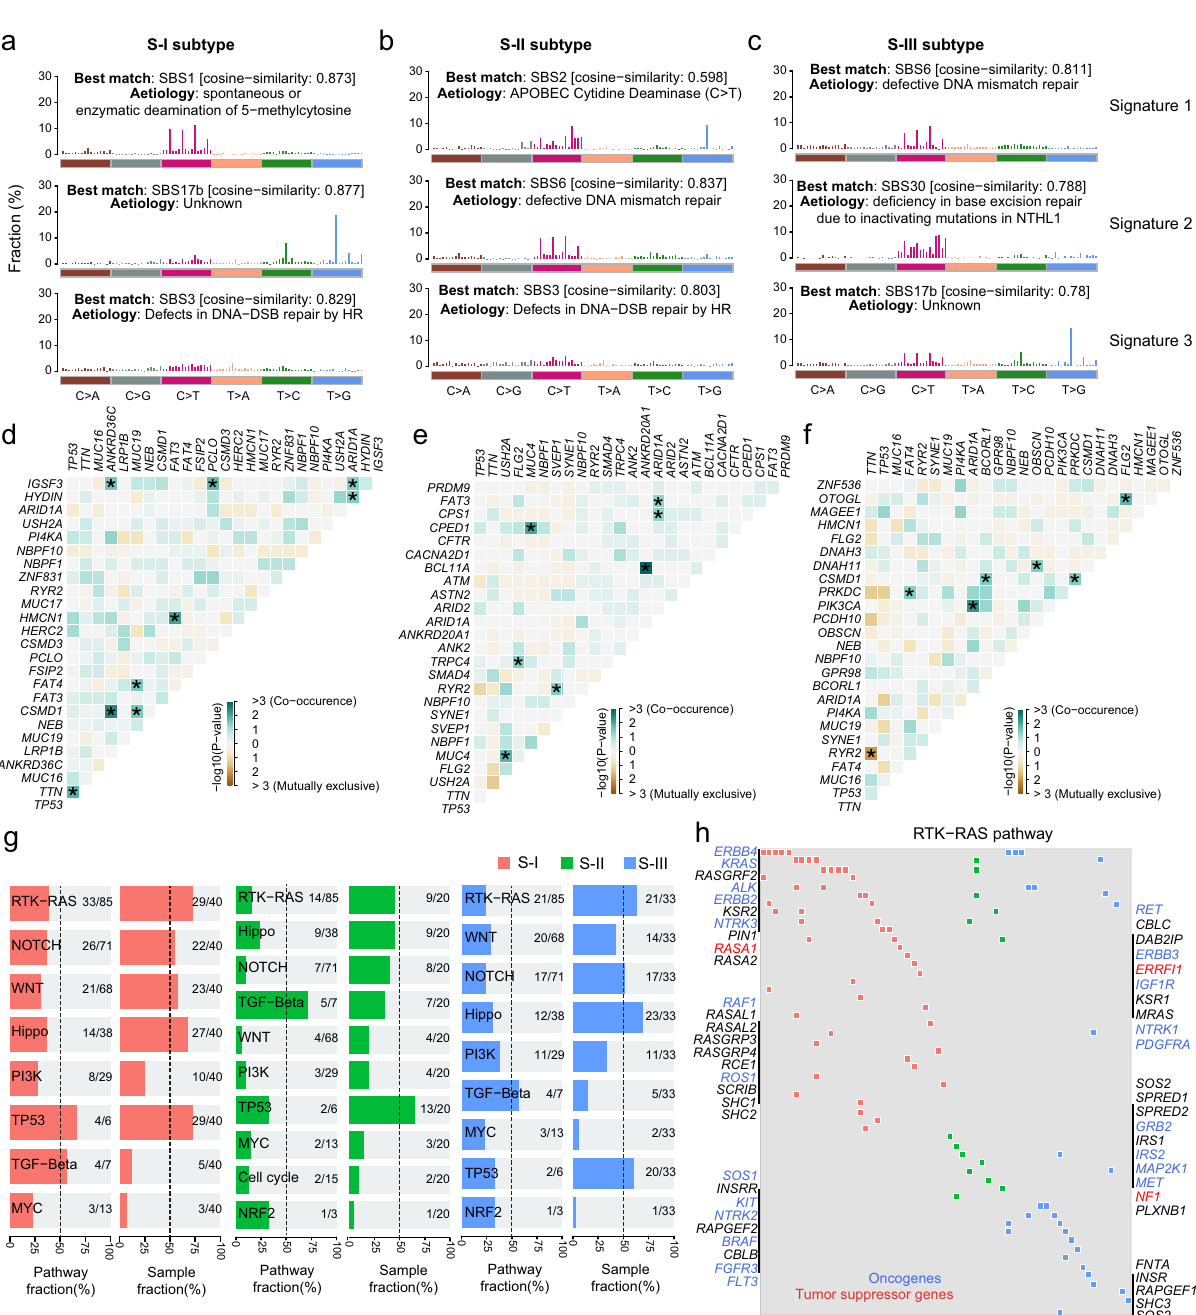
exact test). g Fractions of affected pathways and samples by gene mutations in major oncogenic pathways. h Oncoplot of the RTK-RAS pathway in the three subtypes. Red font indicates tumor suppressor genes and blue font represents